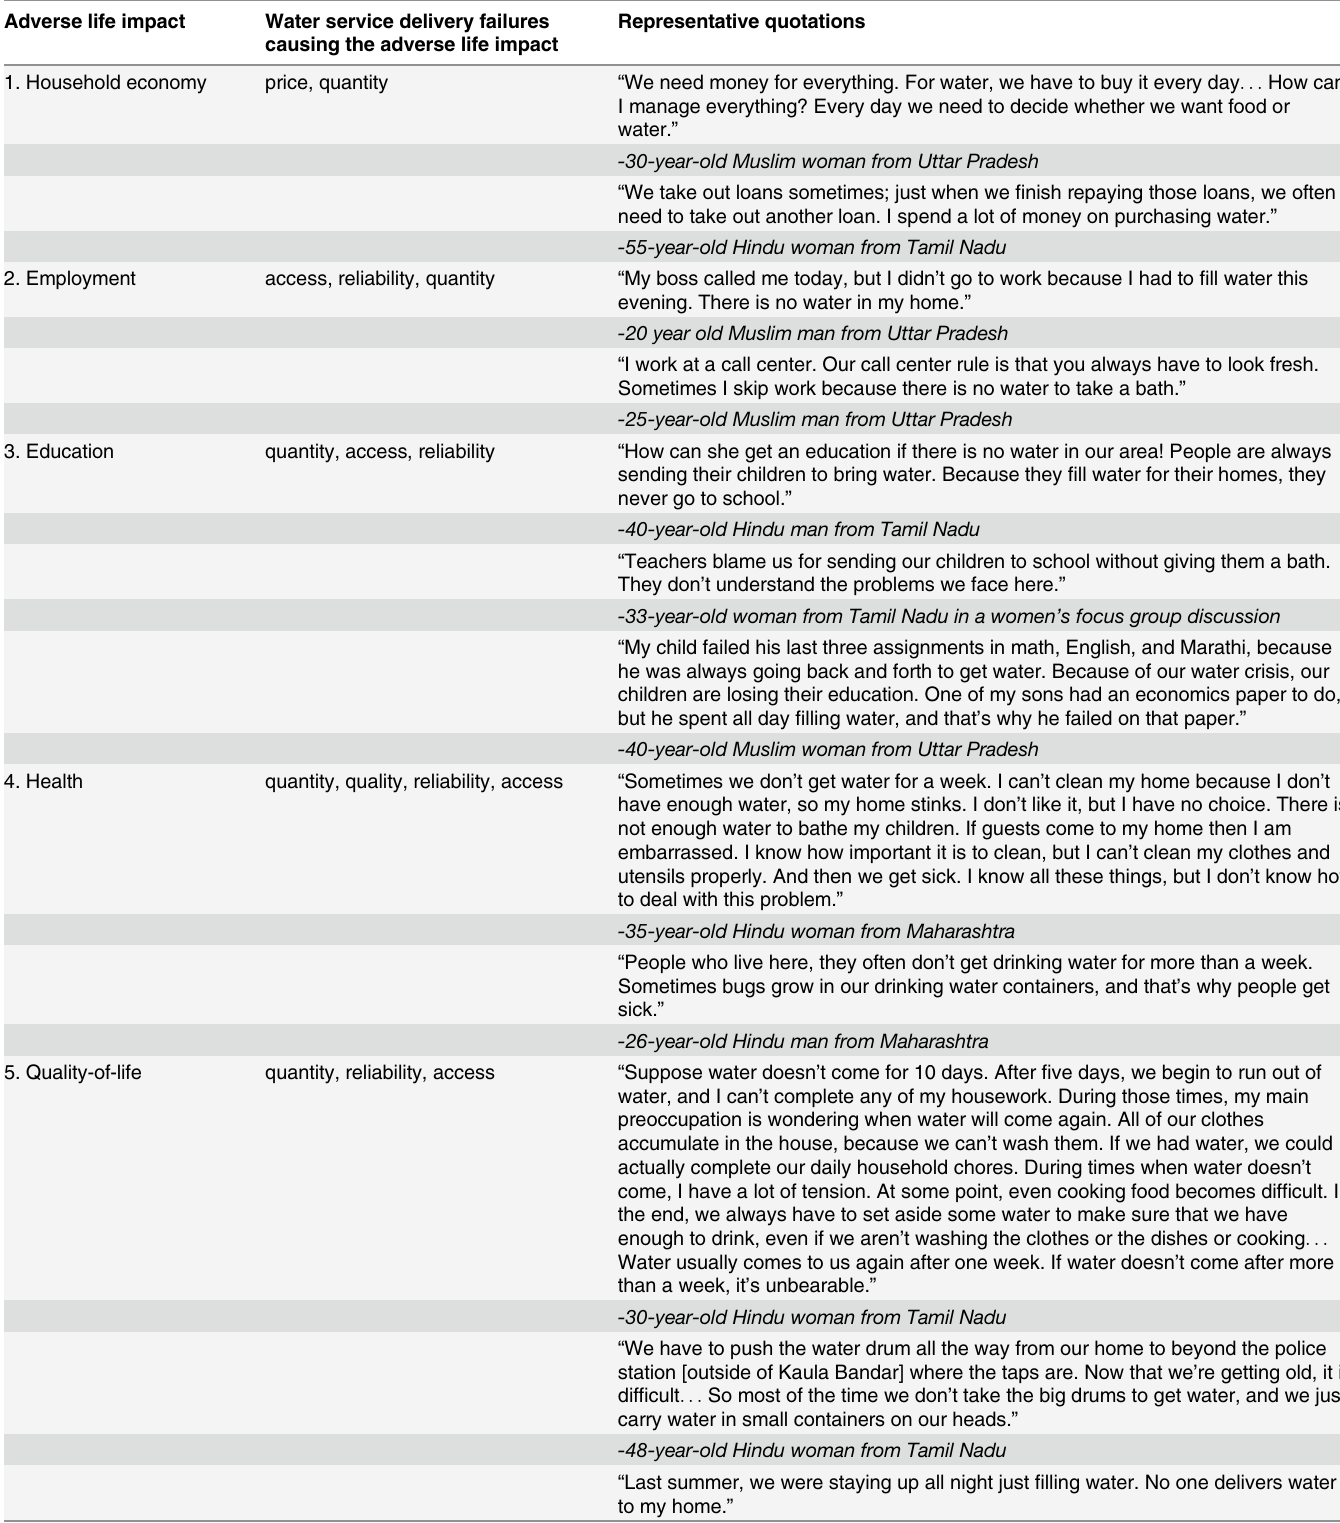
Table 1. Adverse life impacts of deficiencies in water service delivery in Kaula Bandar based on analysis of the qualitative data. Adverse life